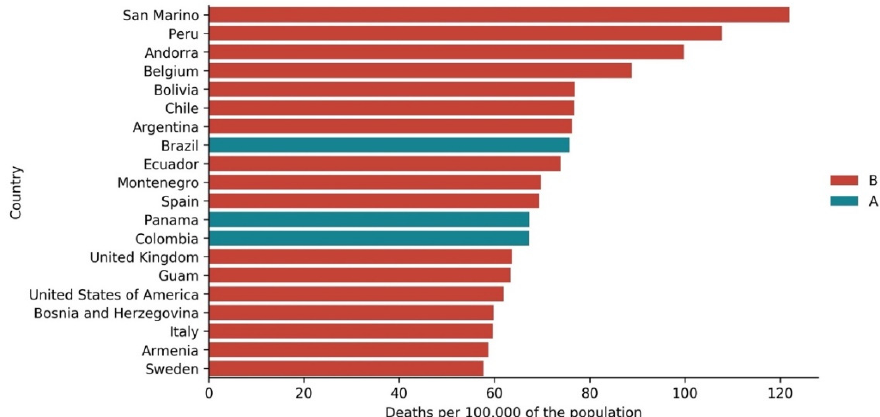
Figure 12. Top 20 total deaths by 100,000 of the population at Day 250 (color indicates the cluster each country belongs to).